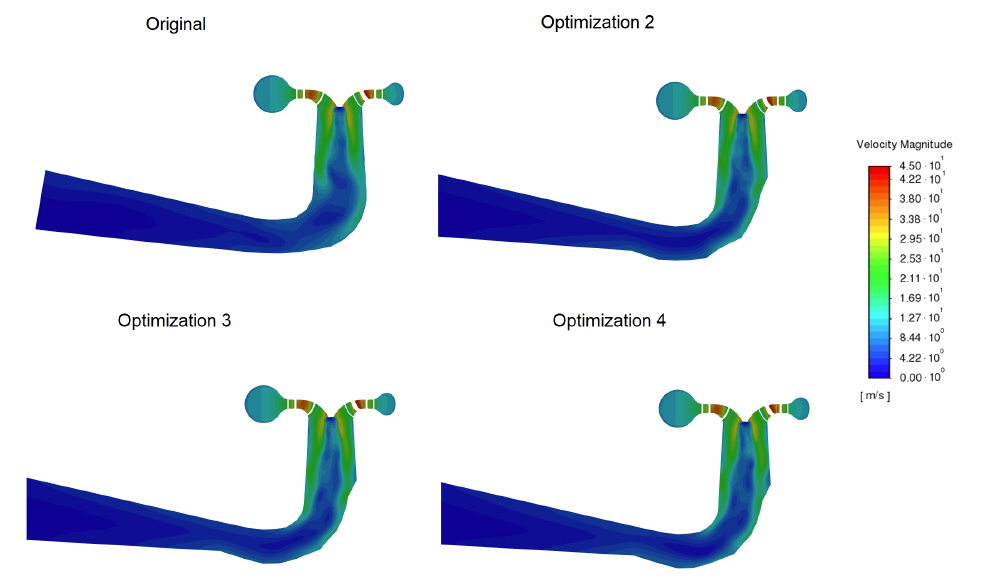
Figure A10. Velocity magnitudes in a longitudinal draft tube cross-section for a 14.3 m 3 /s flow rate.